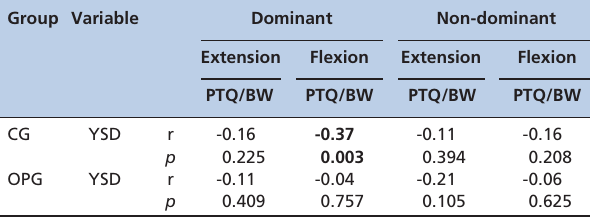
Table 2 - Correlation between muscle strength and anteroposterior COP displacement variables.